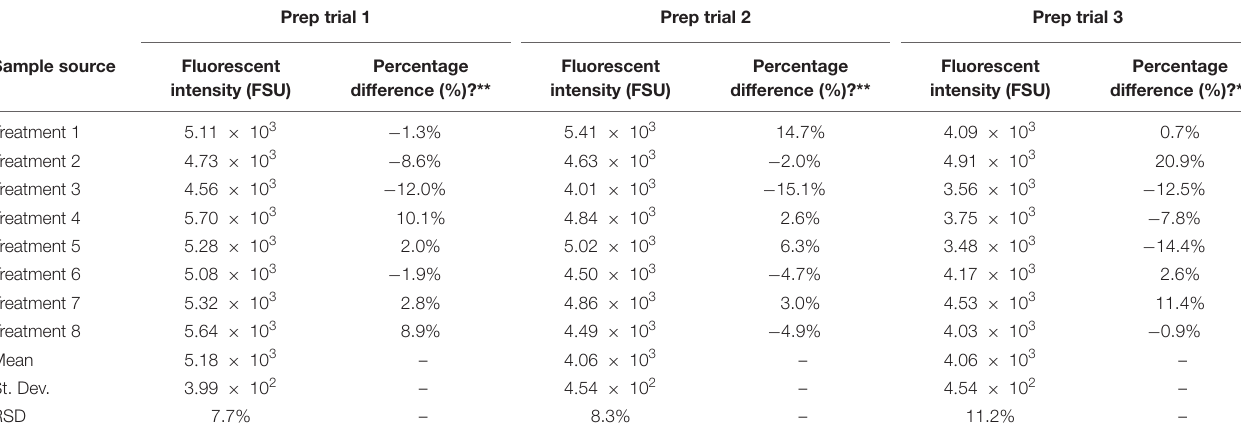
TABLE 6 | Pre-PRRSV experimental verification of air flowrate in each treatment (quartz tubes 1–8) with rhodamine B.